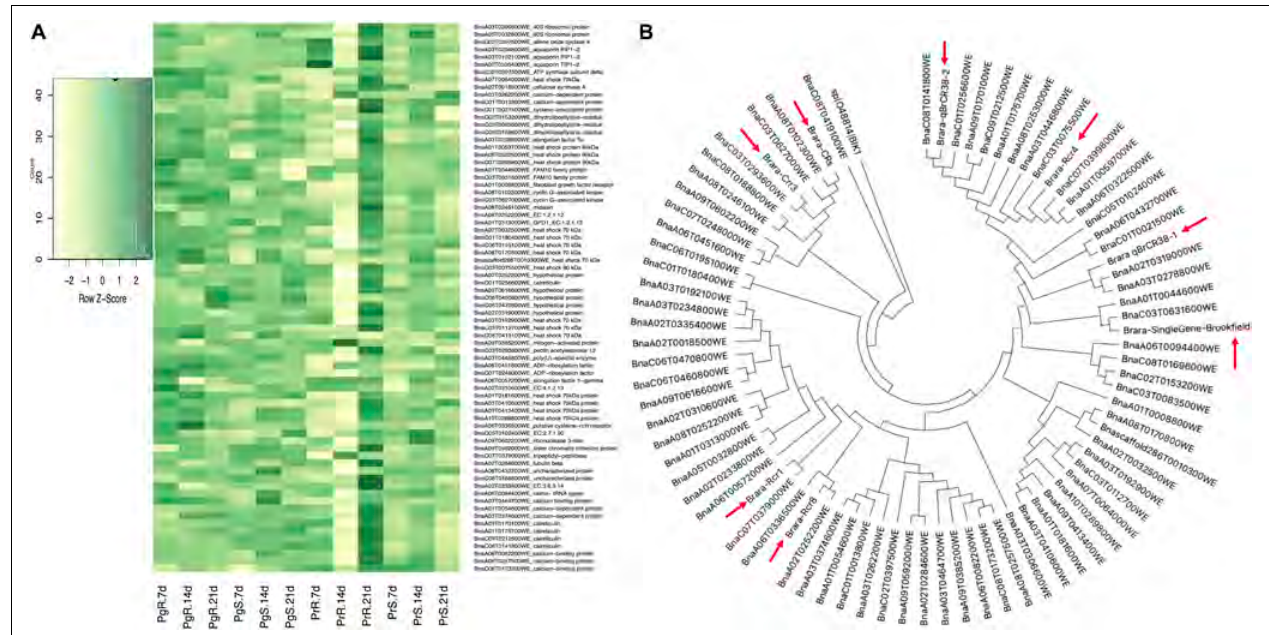
FIGURE 9 | Differentially accumulated proteins (DAP) between inoculated- CR/CS progeny and CR/CS parent, these proteins are orthologous to clubroot resistance related proteins. QTL information (Rcr1, Rcr4, Rcr8, Crr3, CRs, SingleGene-Brookfield, and qBrCR38-2) was obtained from published articles (Hirai et al., 2004; Saito et al., 2006; Chu et al., 2014; Hasan and Rahman, 2016; Yu et al., 2017; Laila et al., 2019; Zhu et al., 2019). The physical location in each chromosome and reference sequence was based on Brassica rapa ‘Chifu-401’ whole genome sequence assembly V3.0 (http://brassicadb.cn/#/syntenic-gene/). (A) Heatmap shows the protein abundance of each CR related proteins at each time point across all genotypes investigated. (B) Dendrogram shows the distribution of putative proteins and the known clubroot resistance related proteins. The red solid arrows indicate the clubroot resistance loci. PgR-7d, CR progeny 7 DPI; PgR-14d, CR progeny 14 DPI; PgR-21d, CR progeny 21 DPI; PgS, CS progeny; PrR, CR parent; PrS, CS